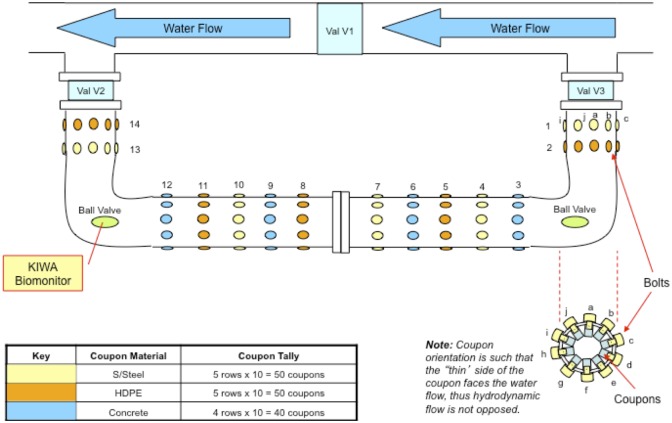
Schematic of MRD detailing the layout of coupons (pipe materials) and connection to the KIWA biofilm monitor.